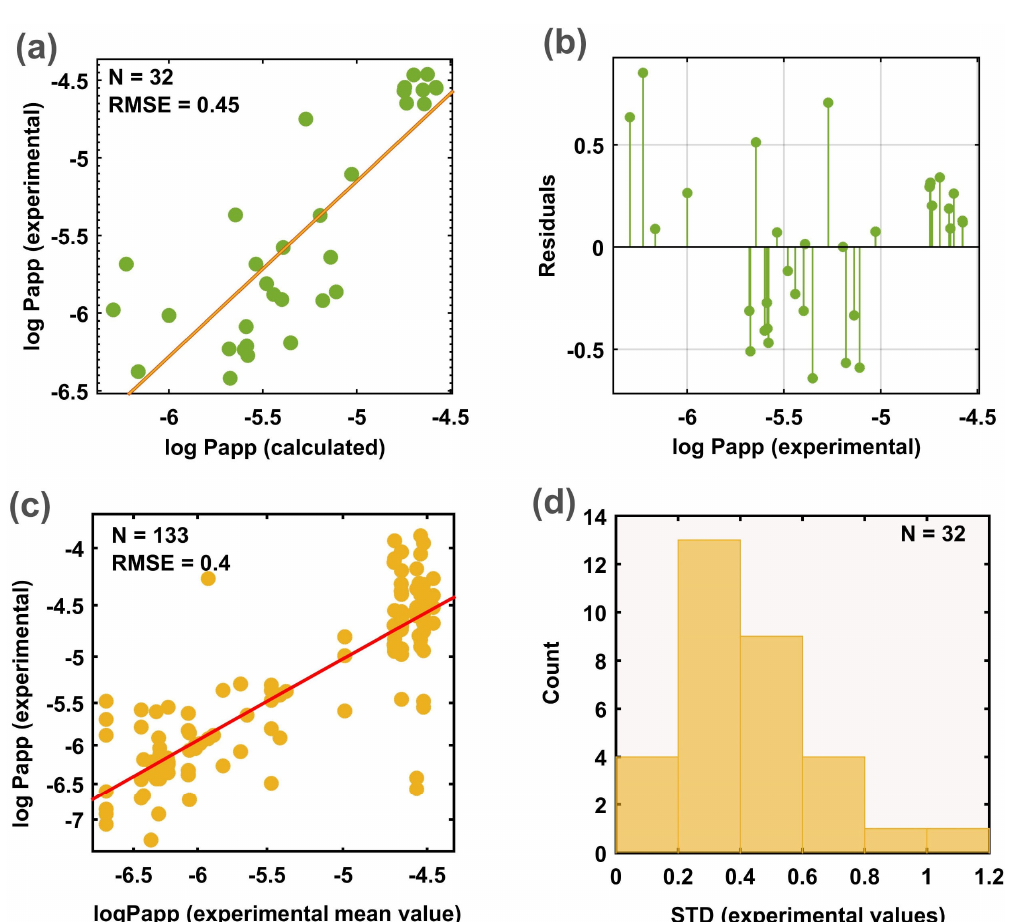
Figure 4. Overview of the model performance on the 32 reference drugs. ( a ) Regression plot for the 32 reference drugs; ( b ) residual plot; ( c ) correlation between the experimental mean value and all the experimental values reported for the same molecule; ( d ) standard deviation distribution of experimental values.